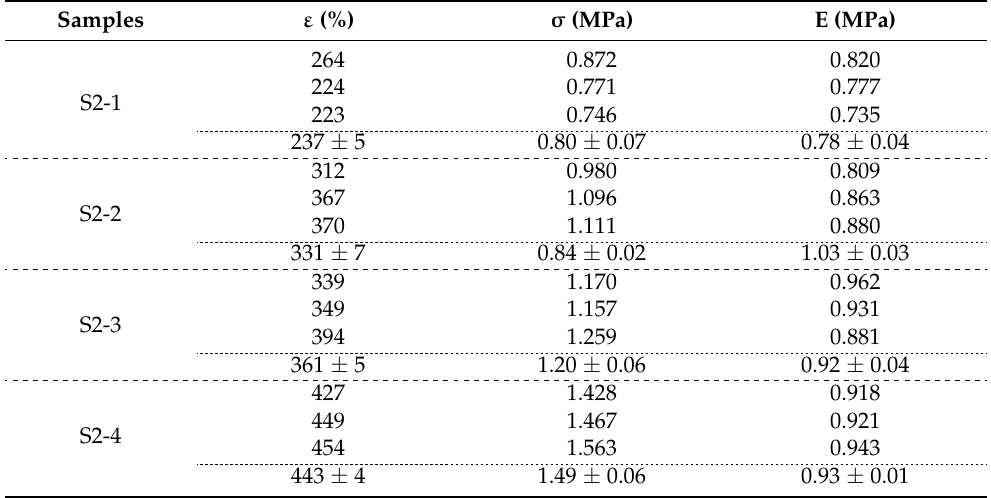
Table 8. Mechanical properties of elastomers with different PEG